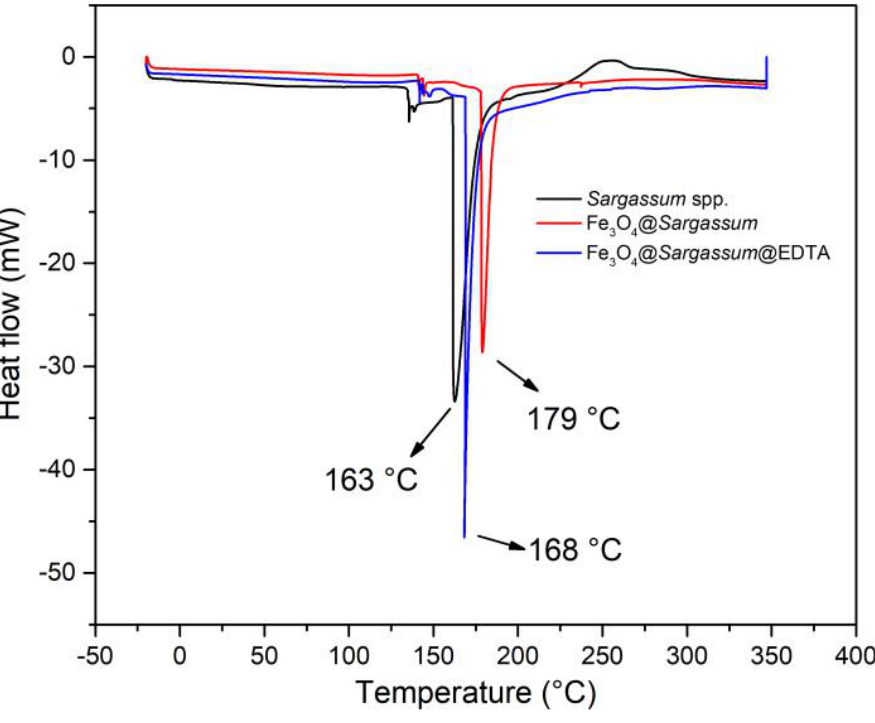
Figure 6. Adsorption DSC measurement curves of Sargassum spp. (black), Fe 3 O 4 @ Sargassum (red), and Fe 3 O 4 @ Sargassum @EDTA (blue).